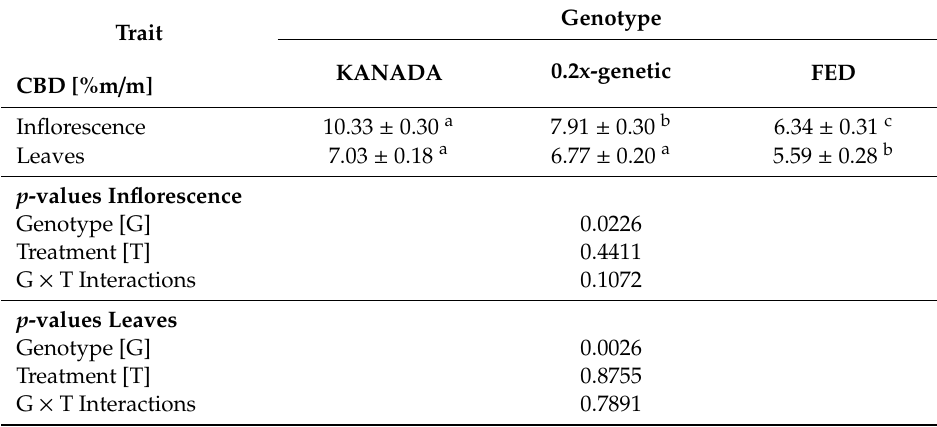
Table 3. Mean content of cannabidiol (CBD) in mass percent [% m / m ] of genotypes KANADA, 0.2x-genetic, and FED. CBD was analyzed in inflorescence and leaves. Results are presented as mean values ± standard error of mean (mean ± SEM). Means in one row followed by at least one identical letter are not significantly di ff erent as indicated by LSD test ( α = 0.05). The p-values correspond to global F tests for di ff erences between the levels of the mentioned genotypes, treatments, or their